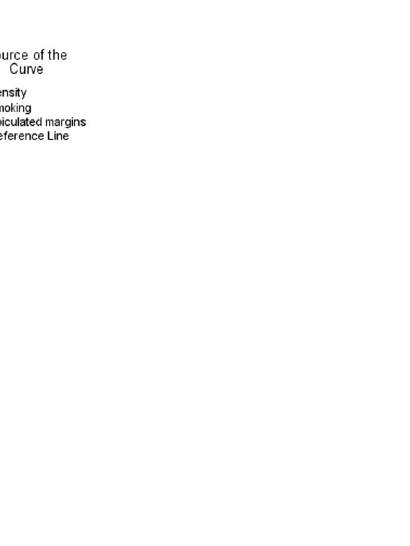
Figure 2. ROC curve for EGFR mutation in exon